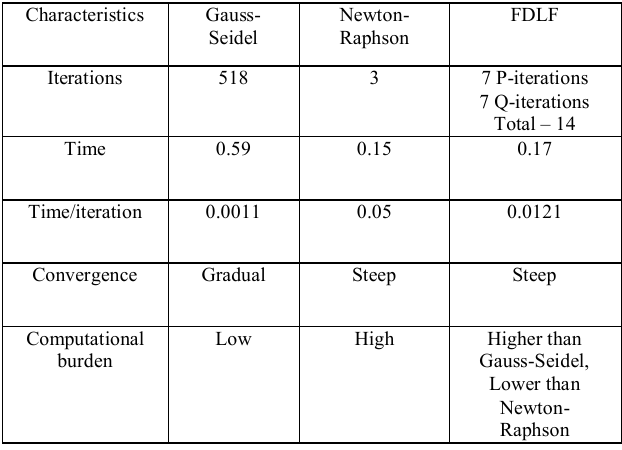
TABLE II LOAD FLOW RESULTS FOR IEEE – 57